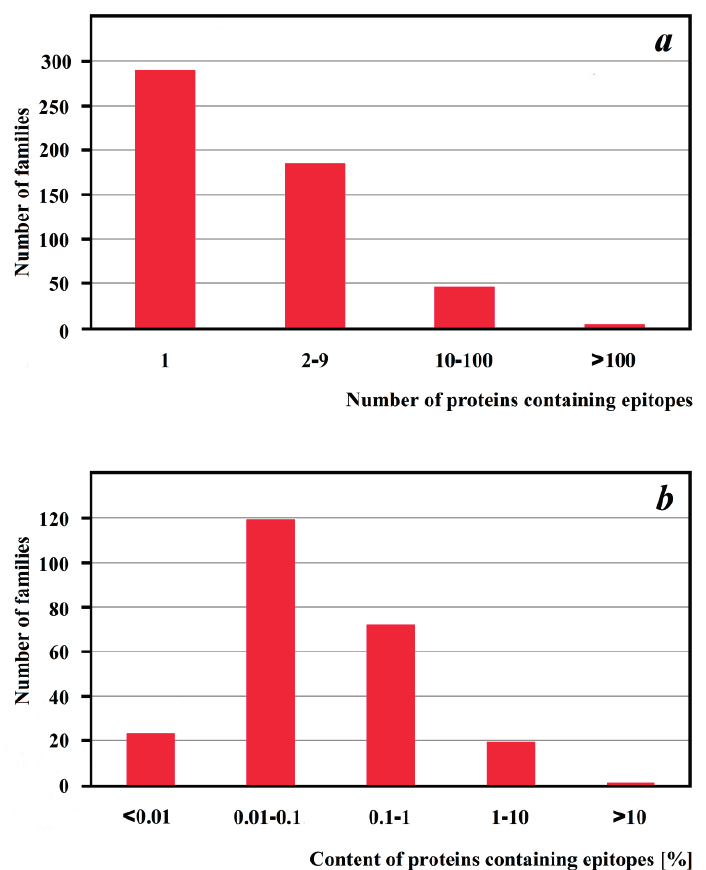
Figure 2. Distribution of proteins containing at least one of the four IgE-binding epitopes of ω 5-gliadin [102] across protein families. ( a ) distribution based on the number of proteins containing epitopes in the family; ( b ) percentage content of proteins with epitopes in the family. The data for families containing at least two proteins with epitopes are shown in b